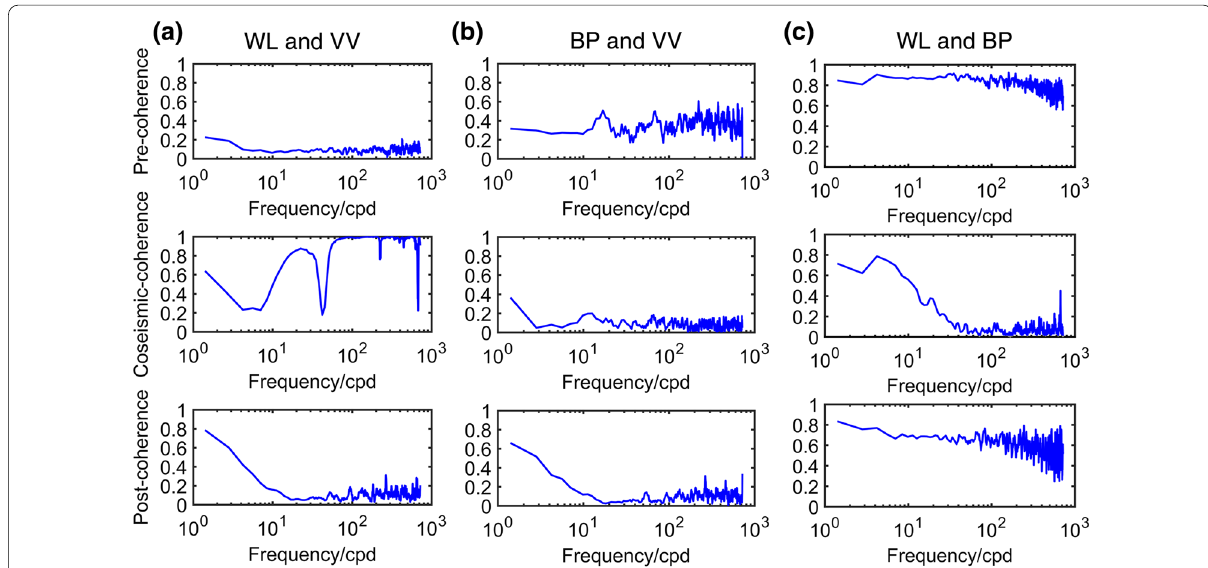
Fig. 5 Gorkha earthquake preseismic, coseismic and postseismic coherences between water level and vertical velocity ( a ), barometric pressure and vertical velocity ( b ), as well as water level and barometric pressure ( c ) in the D22 well. WL, VV and BP are abbreviations of water level, coseismic and barometric pressure, respectively. Figure 6 Gorkha earthquake preseismic, coseismic and postseismic coherences between water level and vertical velocity ( a ), barometric pressure and vertical velocity ( b ), as well as water level and barometric pressure ( c ) in the LJ well. WL, VV and BP are abbreviations of water level, coseismic and barometric pressure, respectively